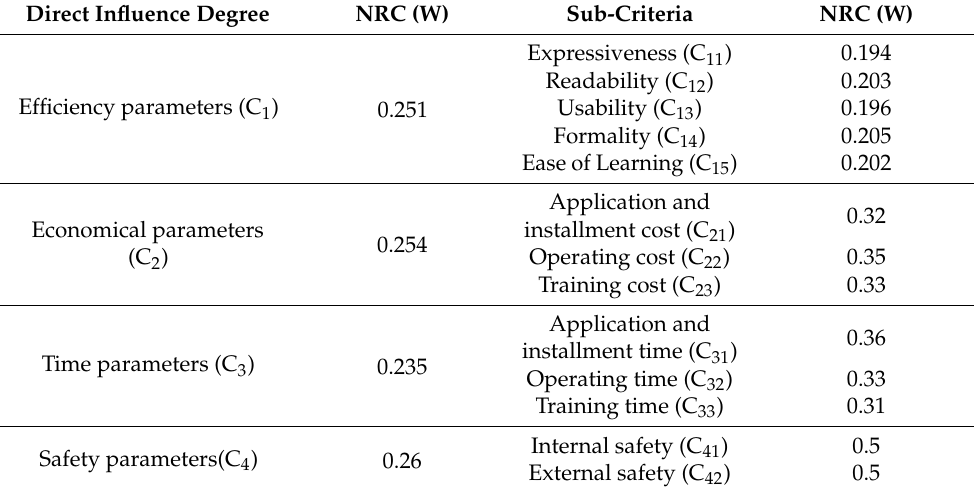
Table 20. Normalized (ro + co) value (weight) for all the all the business process modelling tool selection criteria and